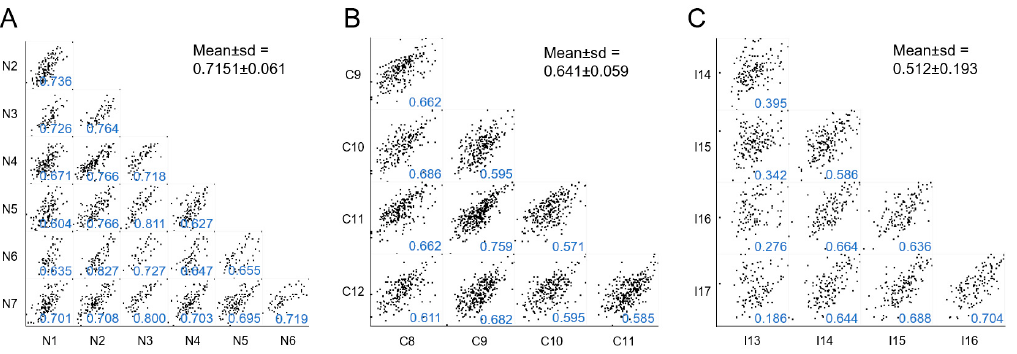
Figure 2. Multi-scatter plots showing correlations of samples within each group: ( A ), NKF; ( B ), CNIT; and ( C ), IFTA. In each individual plot the Pearson correlation coe ffi cients are shown in blue and the corresponding mean ± sd for each group is shown in black.